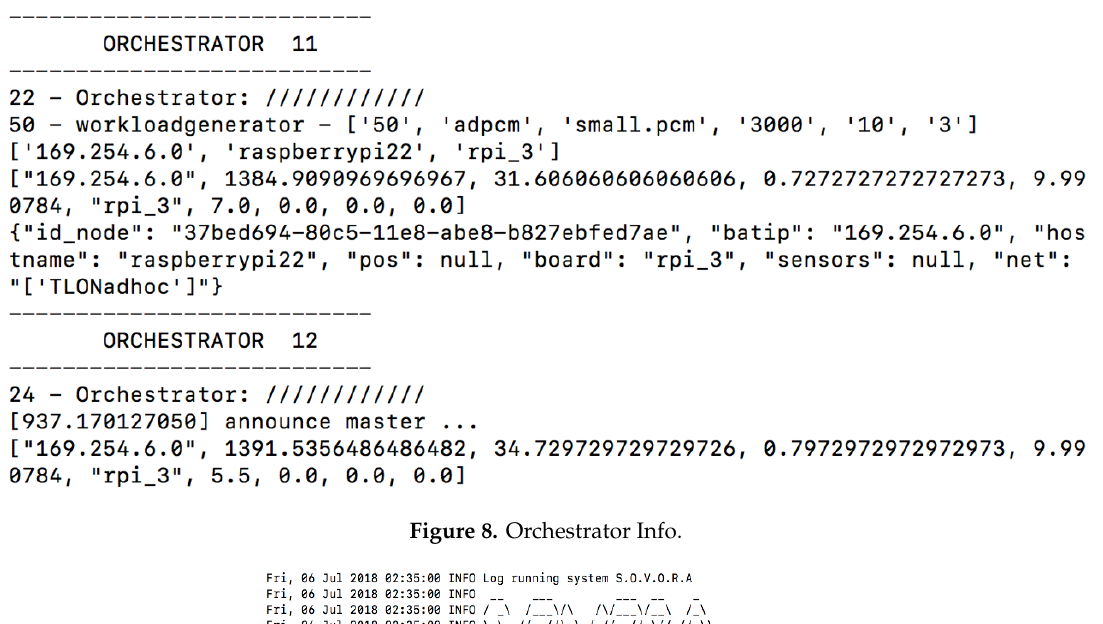
Figure 8. Orchestrator Info.